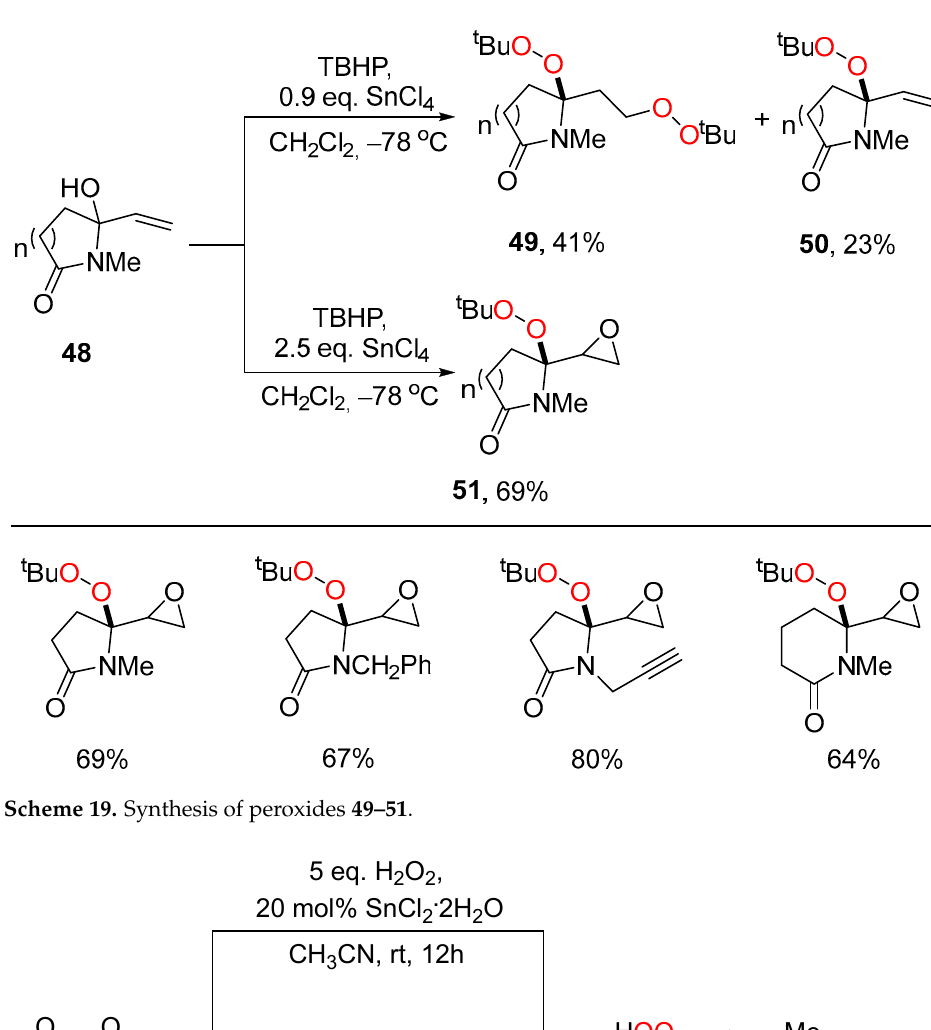
Catalysis of the peroxidation reaction of acetylacetone 52 by strong protic acids